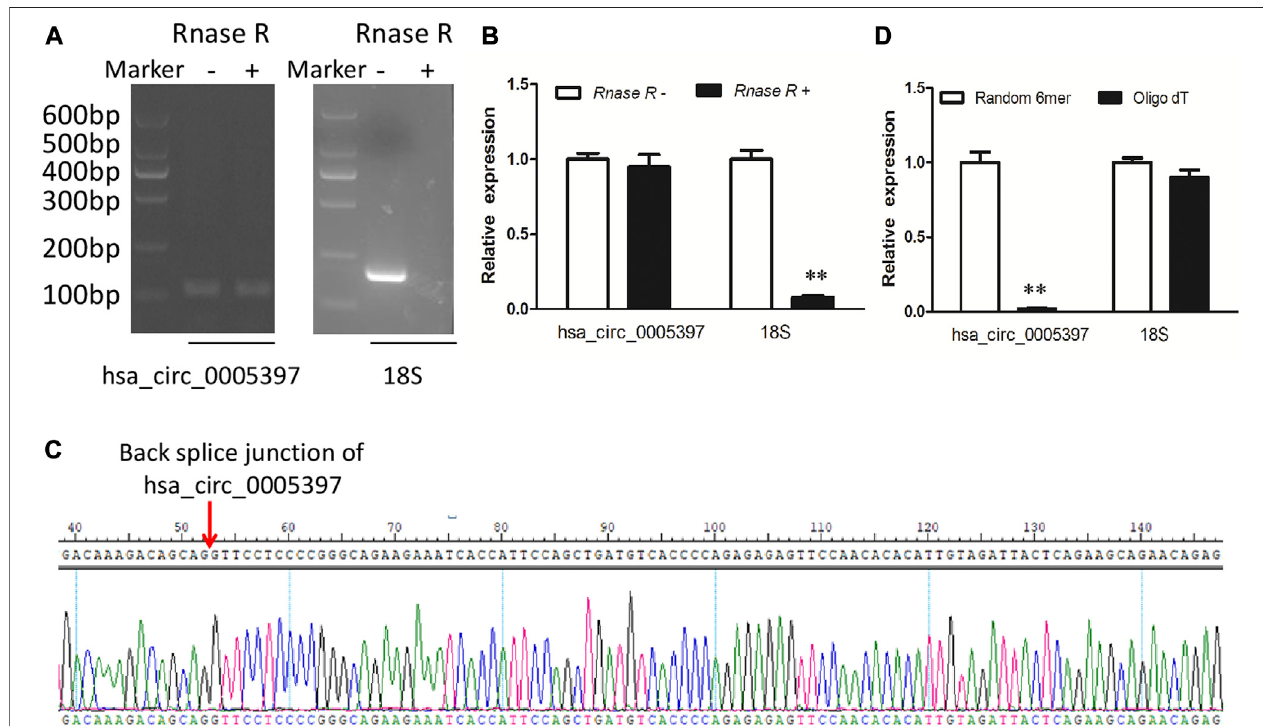
FIGURE 3 | The identi fi cation of plasma hsa_circ_0005397. (A) Total RNA was treated or not treated with RNase R, gel electrophoresis of the RT-PCR products was performed. (B) After pretreated or not pretreated with RNase R, the expression levels of plasma hsa_circ_0005397 and 18S rRNA were detected by qRT-PCR. (C) The qRT-PCR product of the plasma hsa_circ_0005397 was veri fi ed by Sanger sequencing. (D) The cDNA of hsa_circ_0005397 and 18S rRNA were transcribed with random 6-mer or oligo dT primers and then measured by qRT-PCR, ** p < 0.01.